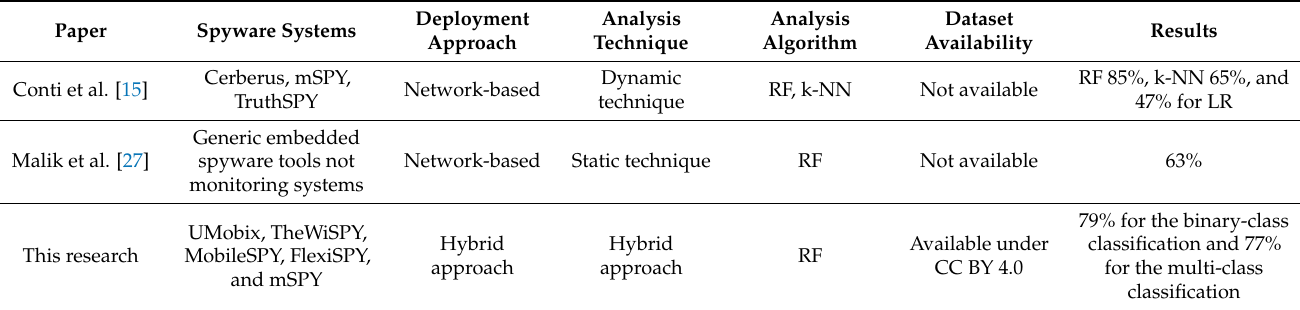
Table 14. Literature comparison